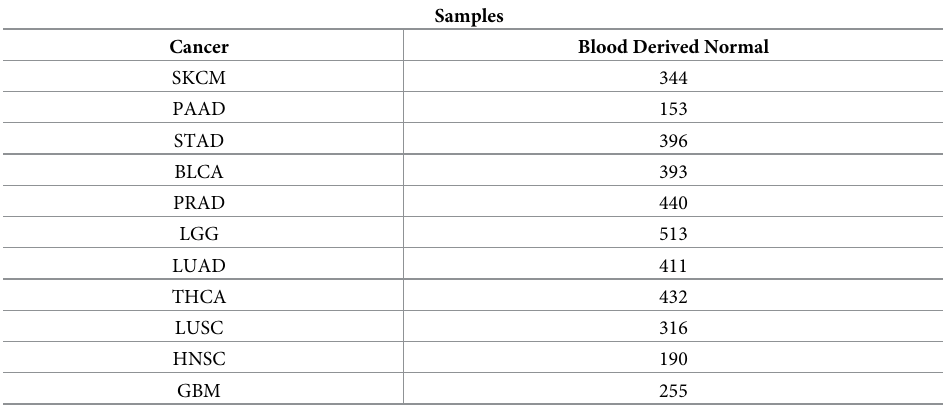
Table 1. Blood-derived WXS DNA samples. Number of samples for each cancer type. In total, the number of blood derived WXS DNA samples are 3874. The sample metadata information is provided in the S1–S11